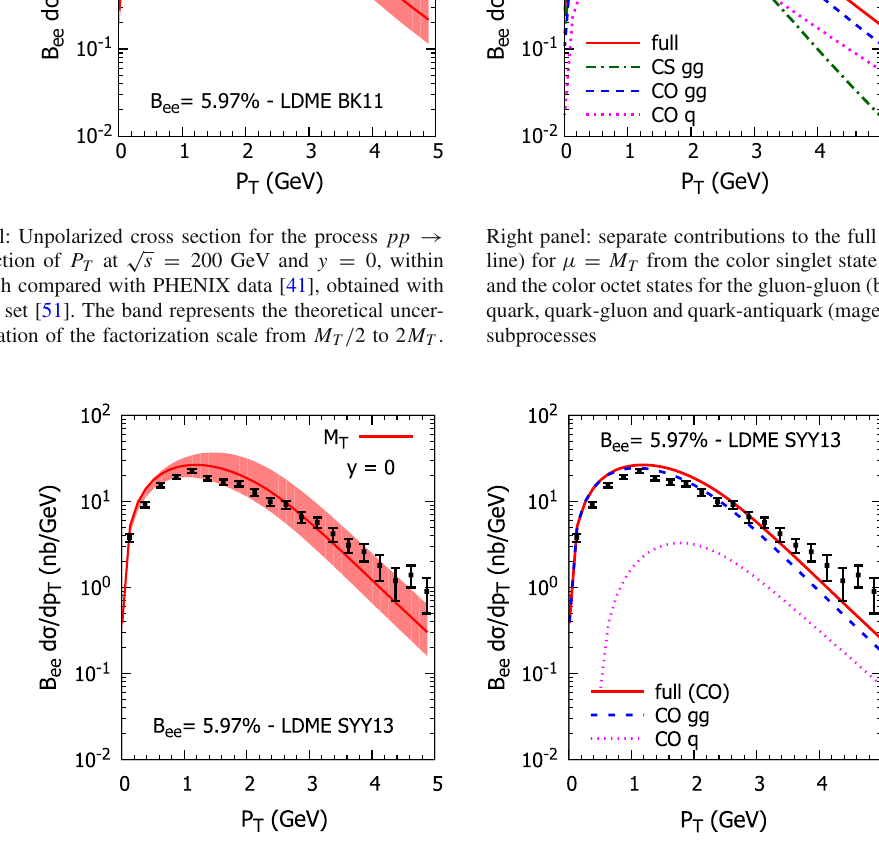
Fig. 2 Left panel: Unpolarized cross section for the process pp → Right panel: separate contributions to the full cross section (red solid √ J /ψ X as a function of P T at s = 200 GeV and y = 0, within line) for μ = M T from the color octet states for the gluon-gluon (blue the GPM approach compared with PHENIX data [41], obtained with dashed line), gluon-quark, quark-gluon and quark-antiquark (magenta the SYY13 LDME set [50]. The band represents the theoretical uncer- dotted line) initiated tainty due to variation of the factorization scale from M T / 2 to 2 M T .